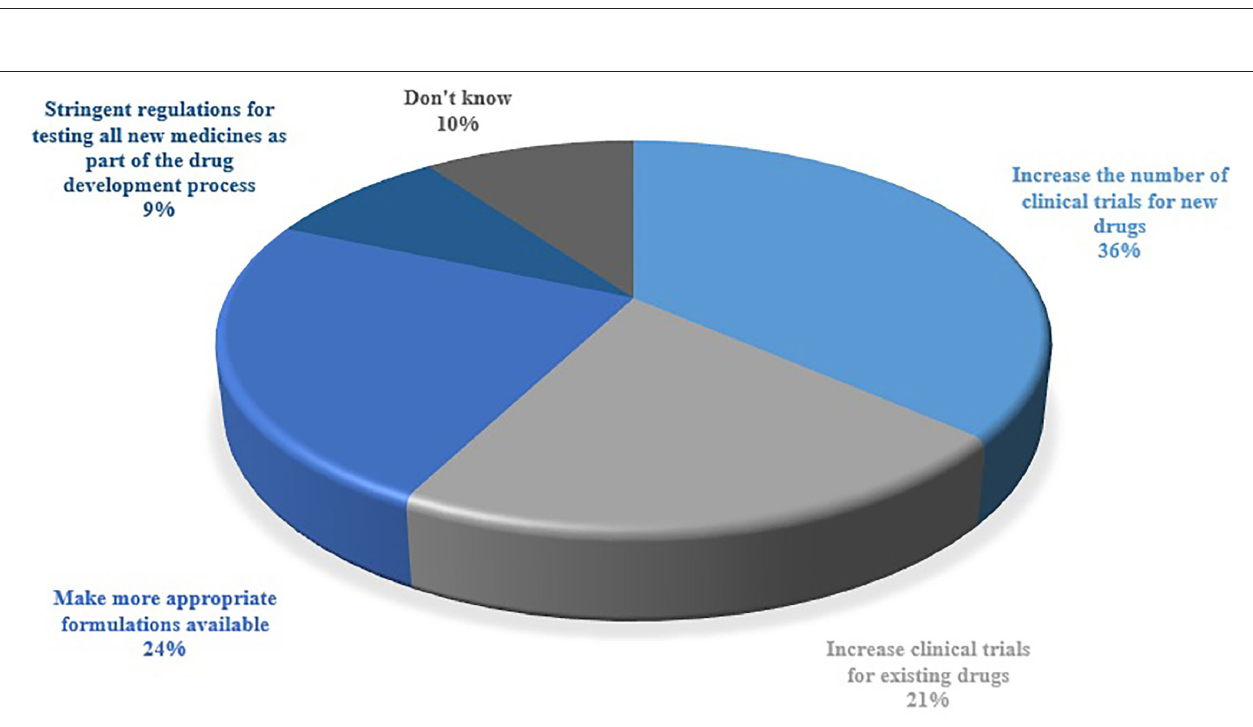
Frontiers in Public Health |